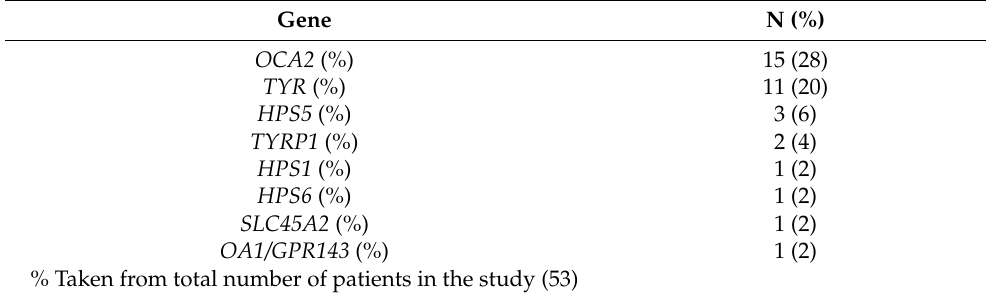
Table 3. Percentage of patients who have P/LP variants in genes associated with positive diagnostic yield.